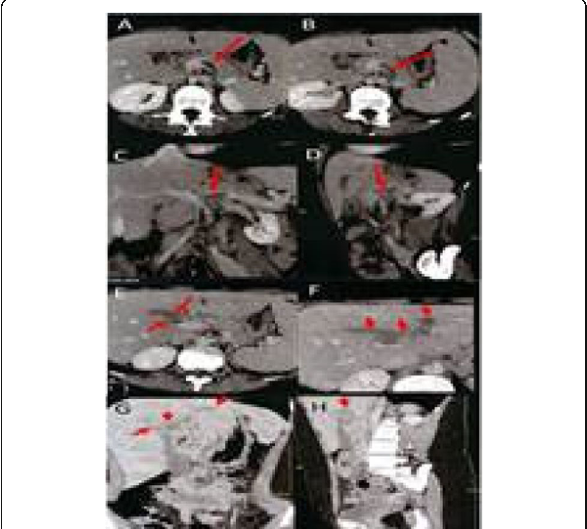
Fig. 1 (abstract P195). Computed tomography images of total abdomen with contrast application showing thrombi in the splenic vein (A and B - axial sections, C - coronal section and D - sagittal section) and in the intrahepatic portion of the portal vein (E and F –